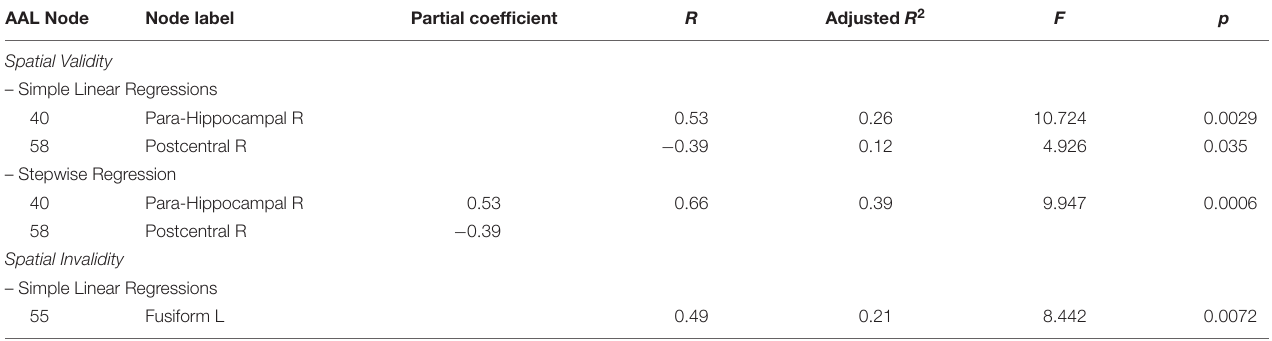
Frontiers in Human Neuroscience |